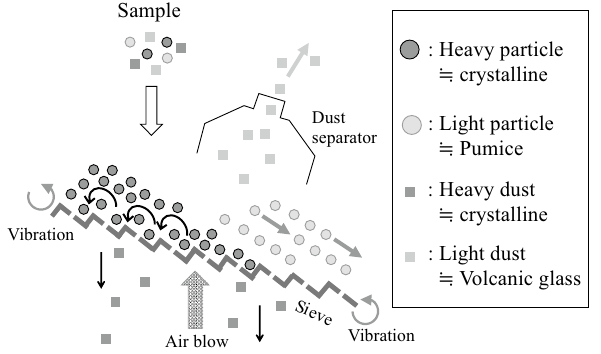
Fig. 2 Mechanism of air table; dry gravity classification. The parti- cles are almost classified according to the density and diameter